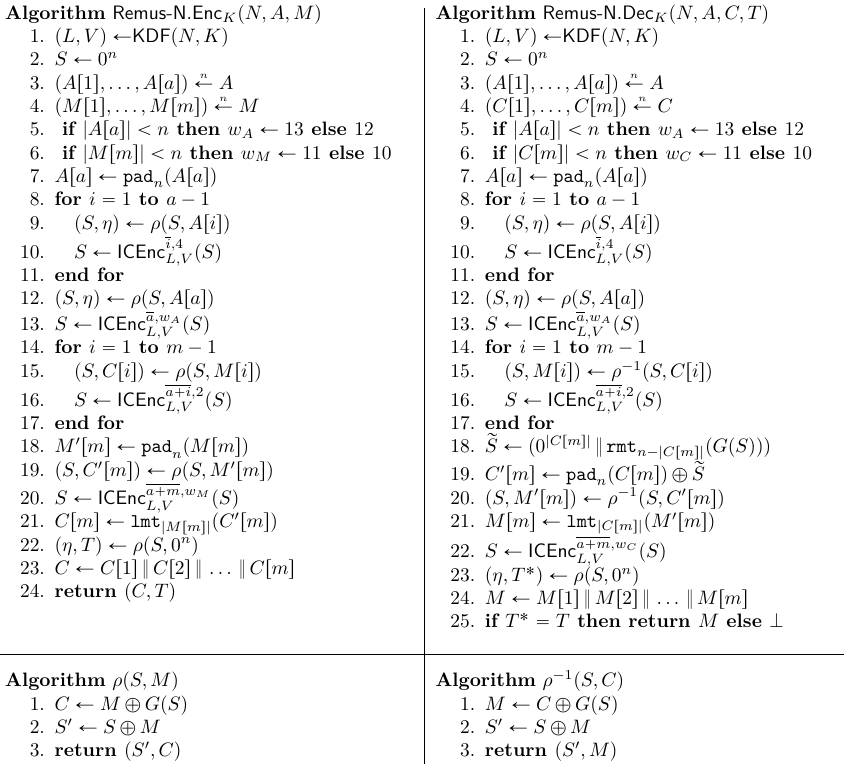
Figure 6: Encryption and decryption of Remus-N . It uses TBC ICE consisting of KDF and ICEnc . Lines of [if (statement) then X Ð x else x 1 ] are shorthand for [if (statement) then X Ð x else X Ð x 1 ] . The dummy variable η is always discarded. Remus - N 1 is